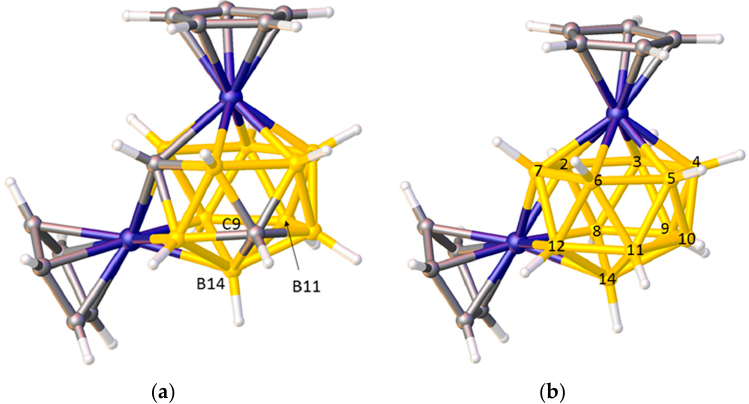
Figure 3. ( a ) The structure of [1,13-Cp 2 - closo -1,13,2,9-Co 2 C 2 B 10 H 12 ]. C9 − B14 1.904(3), B11 − B14 1.858(3) Å; ( b ) The Prostructure of [1,13-Cp 2 - closo -1,13,2,10-Co 2 C 2 B 10 H 12 ] with non-metal vertices numbered.